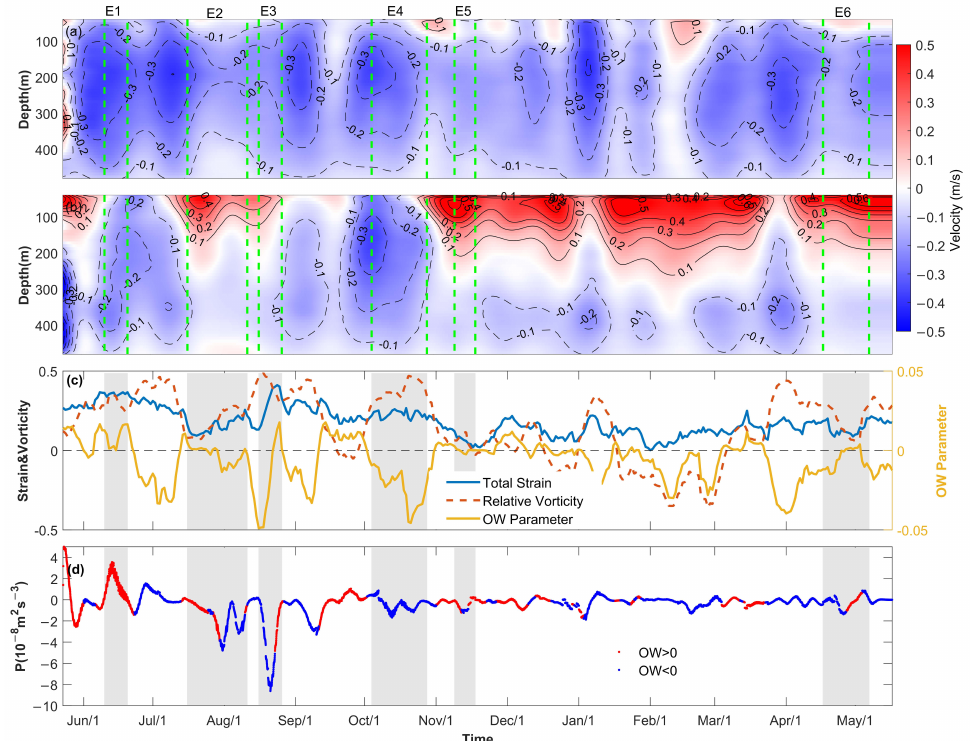
Figure 15. Time–depth plot of cross ( a ) and along the Kuroshio path ( b ) low frequency currents derived from a low-pass filter with pass frequency of 30 days. ( c ) Time series of total strain (blue line, left axis), relative vorticity (red line, left axis), and Okubo–Weiss parameter (yellow line, right axis). Total strain and vorticity are normalized by local inertial frequency and the Okubo–Weiss parameter is normalized by the square of the local inertial frequency ( f 2 ). ( d ) Time series of the rate of energy transfer from mesoscale fields to internal waves. Red (blue) color denotes positive (negative) Okubo–Weiss parameter. The periods of each episode are marked by green rectangles in ( a , b ), and are grey shaded in ( c , d